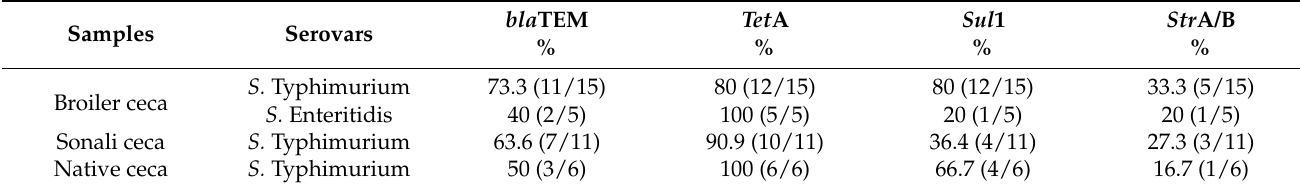
Table 3. Prevalence of AMR gene in S . Typhimurium and S . Enteritidis in different chicken.